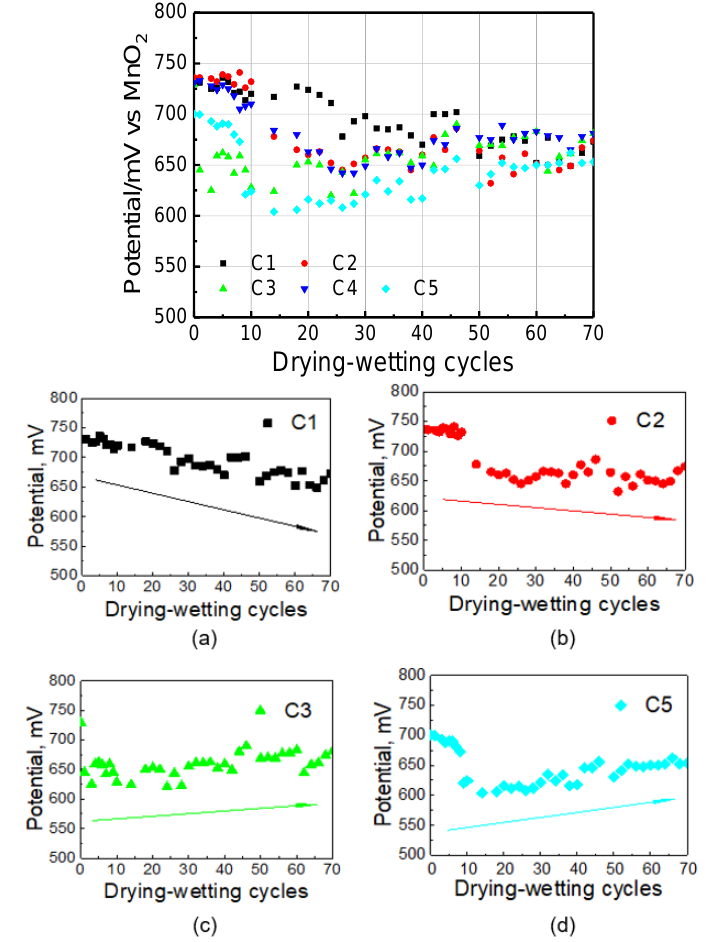
Figure 5. Potential evolution with the development of dry-wet cycles of Ag/AgCl electrodes in mortar sample.